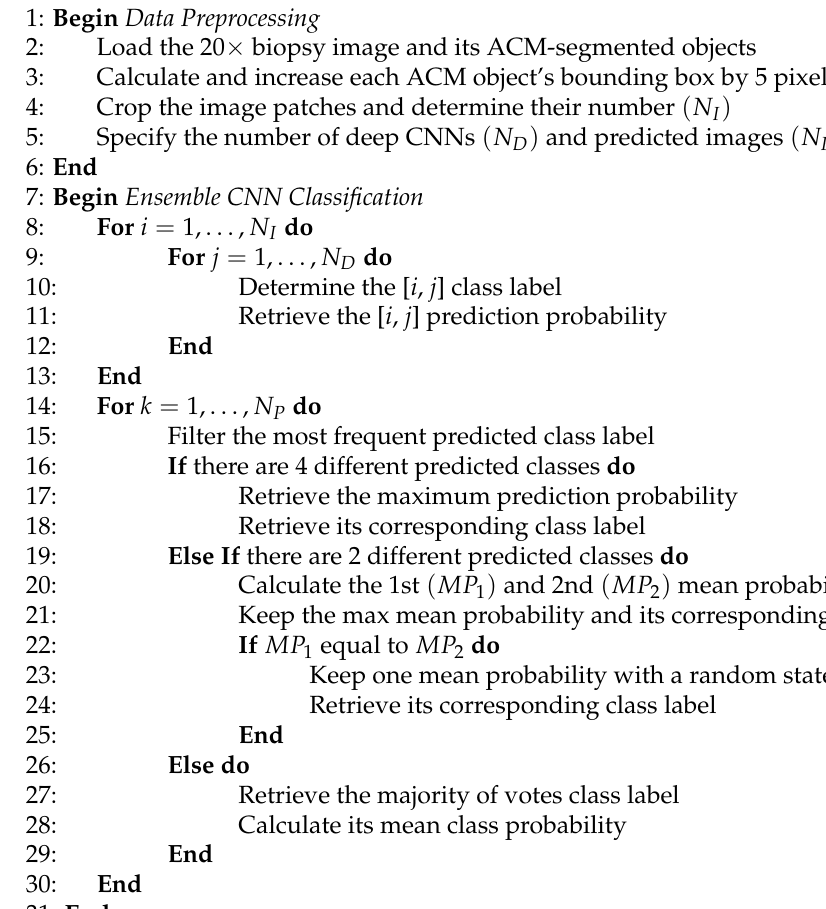
Algorithm 1 Ensemble CNN